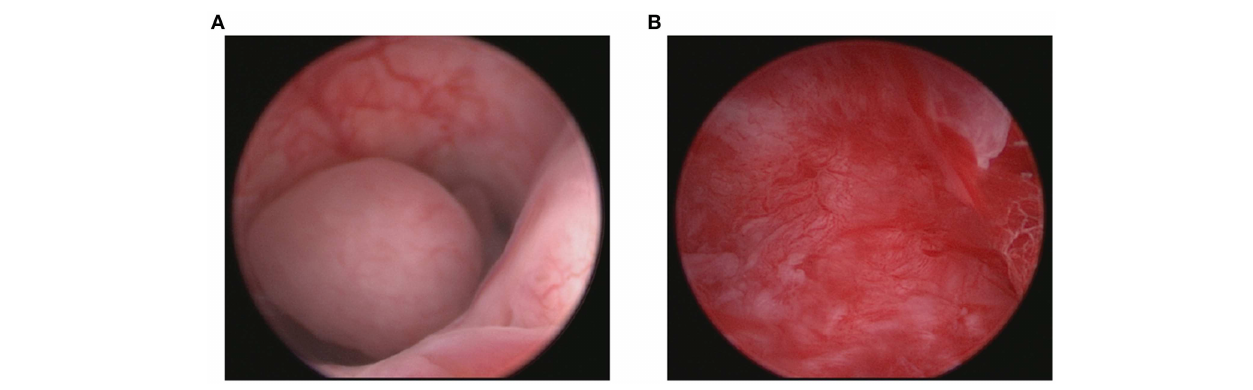
Contraception NED